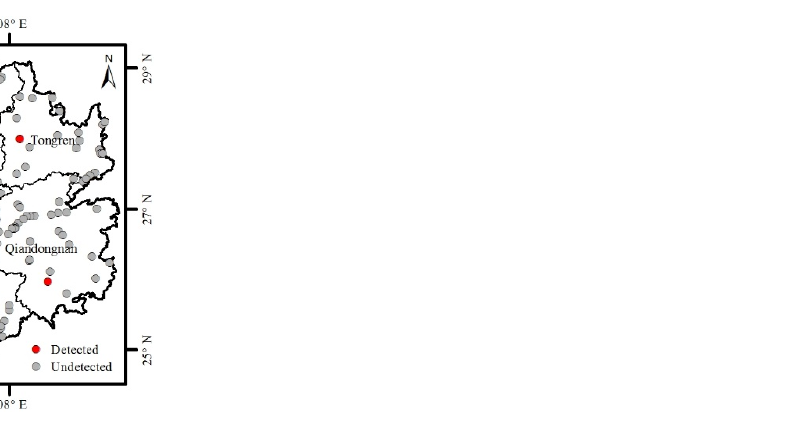
Figure 2. Distribution of malignant invasive species (Level 1). Red and grey dots indicate detected and undetected invasive species, respectively.